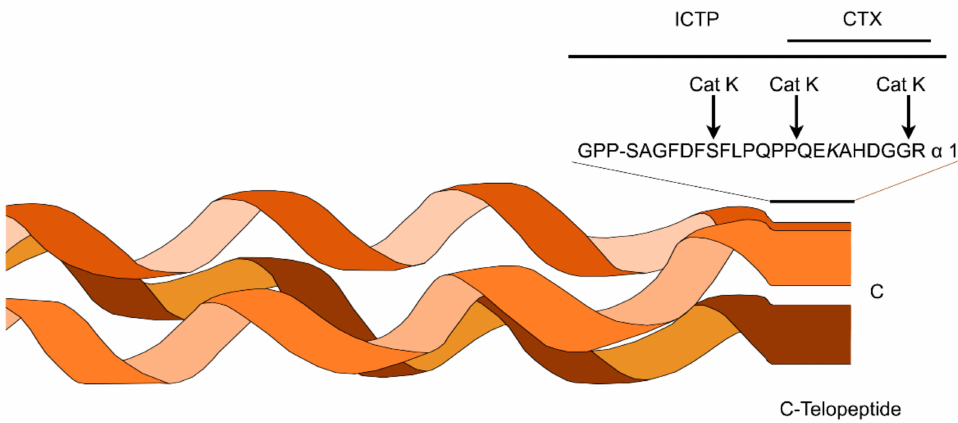
Figure 9. CTX and ICTP are epitopes that can be used as bone resorption markers on cathepsin K (Cat K) and type I collagen cleavage sites. In this schematic representation the structures of CTX and ICTP are represented. CTX epitope comprises an eight amino acid sequence on the α -1 C-telopeptide, while the ICTP one exhibits a larger conformation with two telopeptides and the first phenylalanine of the phenylalanine rich region Cathepsin K degrades the ICTP epitope, while generating CTX.